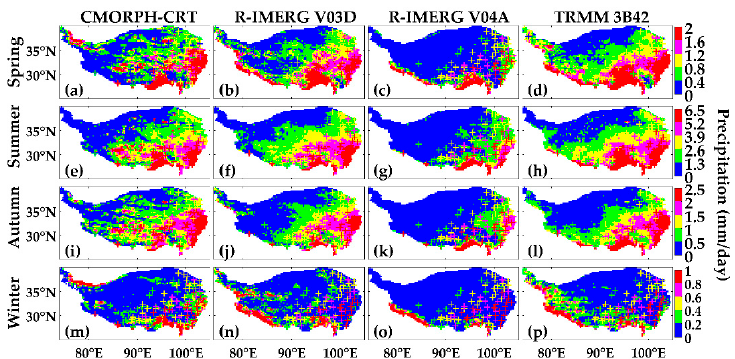
Figure 4. Maps of seasonal daily average precipitation (mm/day) at a 0.25° spatial resolution derived from CMORPH-CRT ( a , e , i , m ); R-IMERG V03D ( b , f , j , n ); R-IMERG V04A ( c , g , k , o ) and TRMM 3B42 ( d , h , l , p ) estimates for spring, summer, autumn and winter over the Tibetan Plateau between June 2014 and November 2015. The pluses represent seasonal daily average precipitation (mm/day) of gauge precipitation estimates (sampled between 1 June 2014 and 30 November 2015).